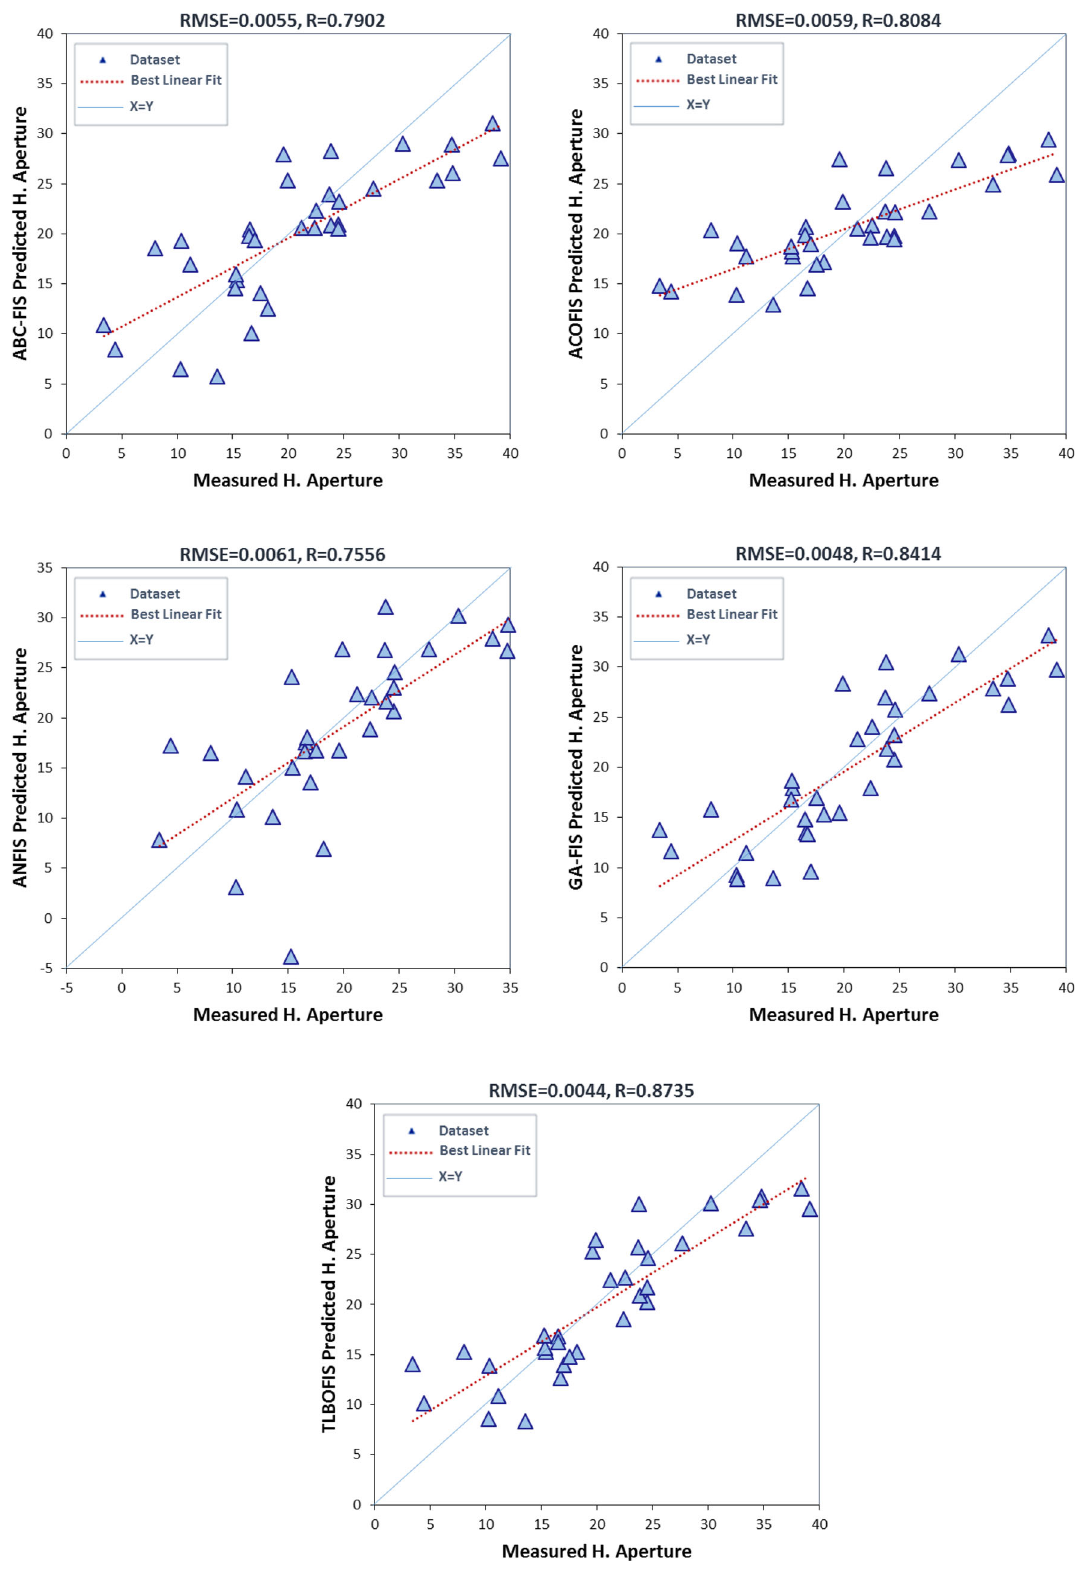
Fig. 9 Cross-plots showing correlation between the measured and estimated values of aperture size, for each